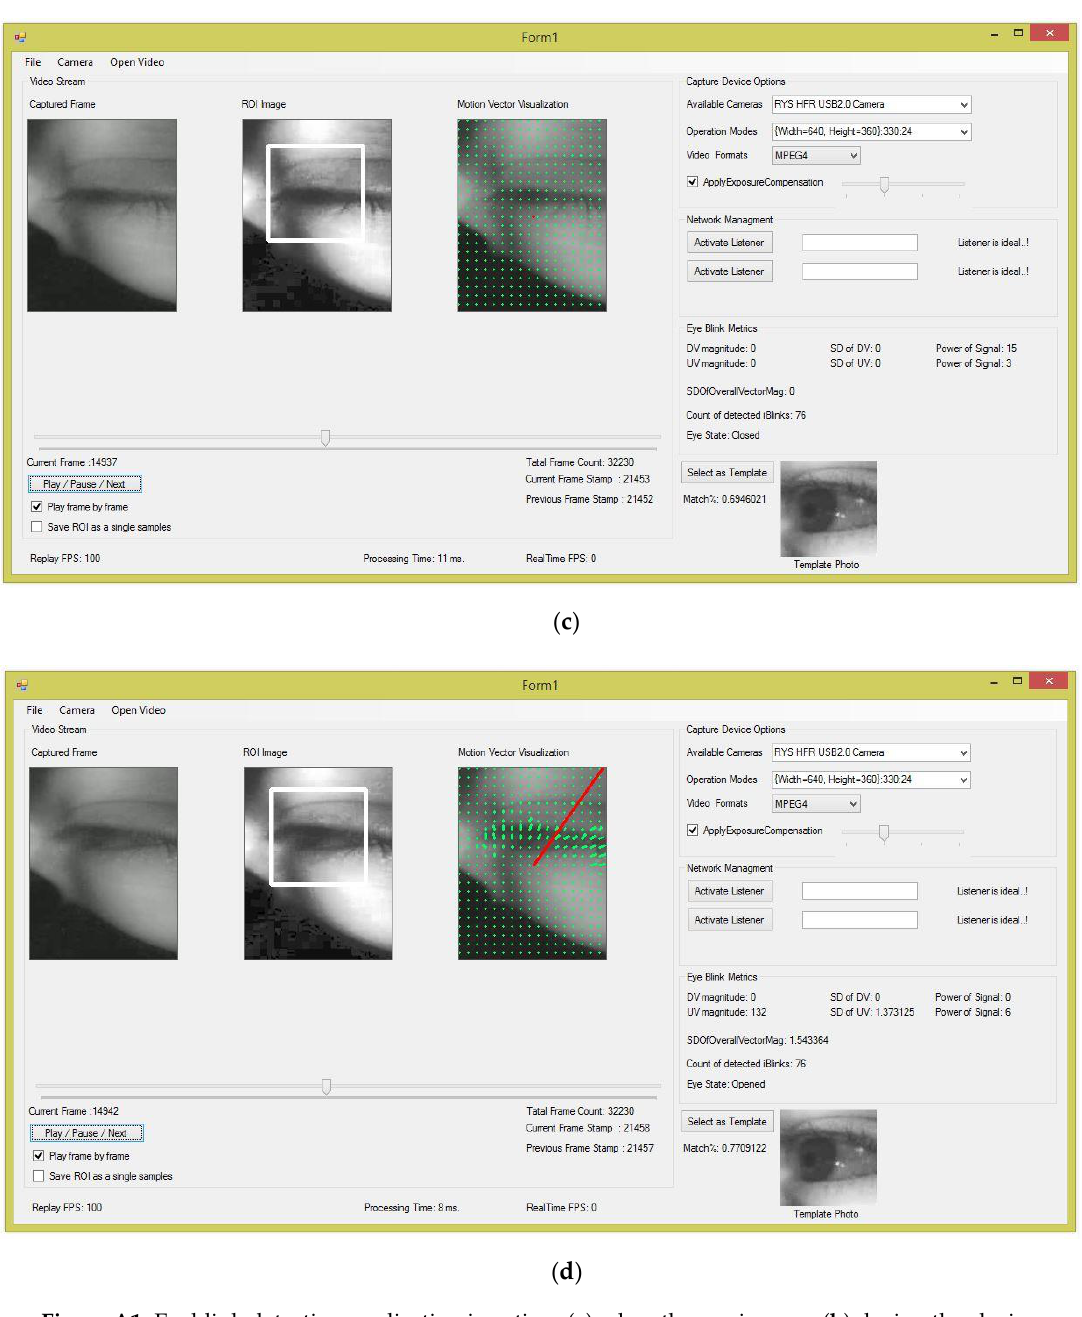
Figure A1. Eyeblink detection application in action: ( a ) when the eye is open; ( b ) during the closing phase; ( c ) during the pause phase; ( d ) during the reopening phase.